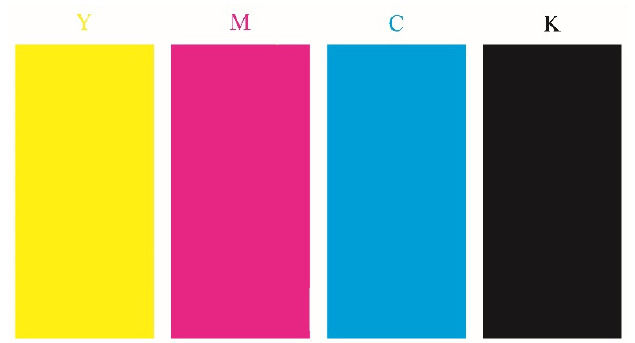
Figure 19. Design drawing of color printing sample.